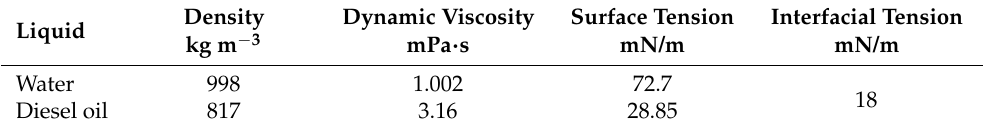
Figure 4. The head-on collision processes between a water droplet and a diesel droplet at different Weber numbers. Table 2. Physical parameters of the